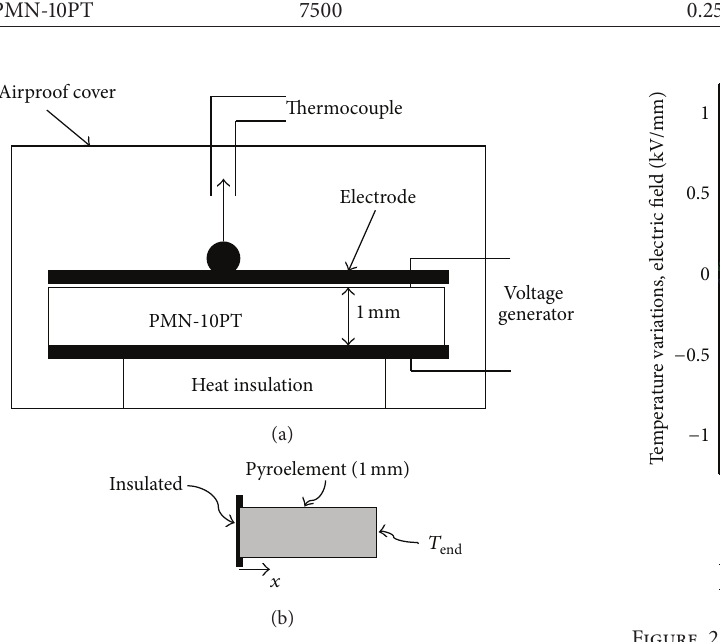
Figure 2: Electrocaloric response of PMN-10PT to the applied bipolar electric